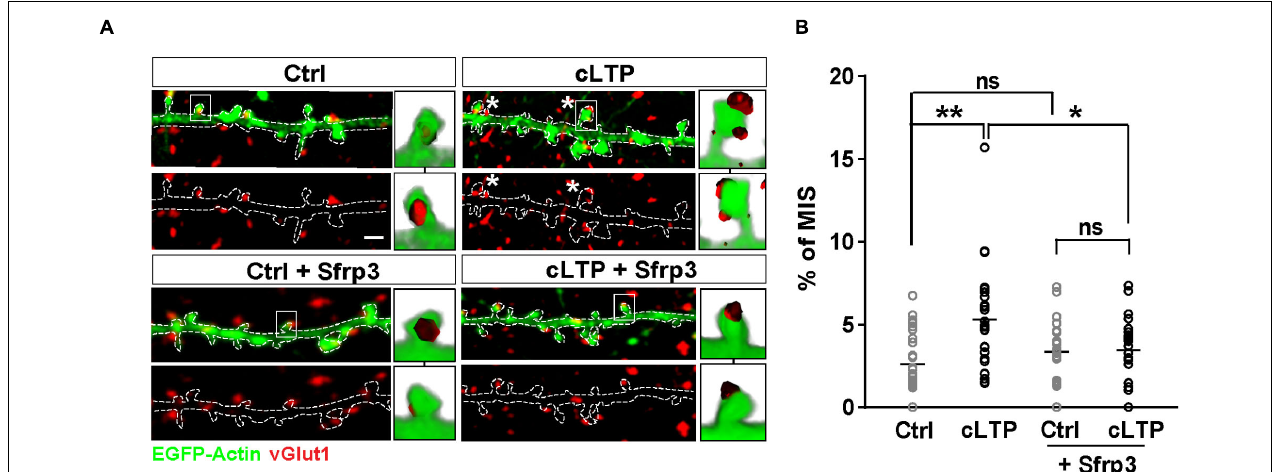
FIGURE 1 | LTP-mediated increase in MIS number requires endogenous Wnts. (A) EGFP-actin-expressing cultured neurons (13–14 DIV) (in green) exposed to control (Ctrl) or cLTP conditions, with or without the specific Wnt antagonist Sfrp3 and immunostained for vGlut1 (in red). cLTP induction increased the proportion of spines contacted by more than one vGlut1 puncta (MIS; asterisks). However, this effect was blocked by Sfrp3. Three-dimensional zoomed-in images display front (top) and back (bottom) representations of innervated spines with single or multiple vGlut1 puncta. Scale bar = 1 µ m. (B) Quantification of mean percentage of MIS in each condition ( n = 25–31 cells/condition from 3 independent cultures, * P < 0.05 and ** P < 0.01 by two-way ANOVA followed by Tukey post hoc